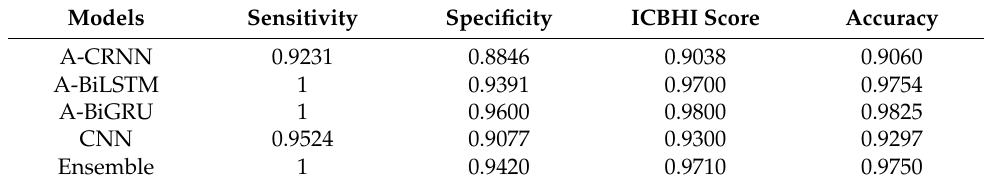
Table 16. Results of base and ensemble models for D2, i.e., the Coswara cough dataset.